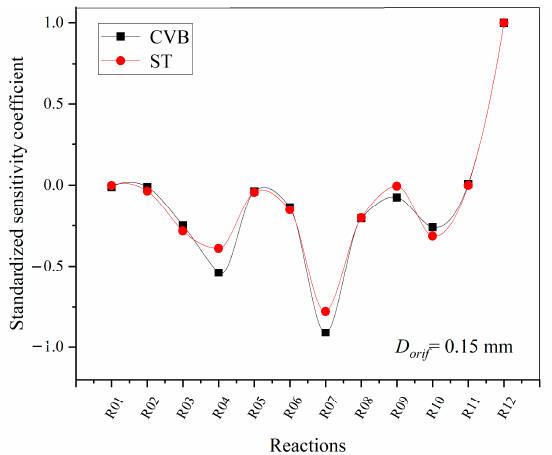
Figure 11. Normalized sensitivity coefficient for CVB versus a shock tube (initial temperature of 850 K for a shock tube; ambient temperature of 1000 K for 850 K for a shock tube; ambient temperature of 1000 K for CVB).